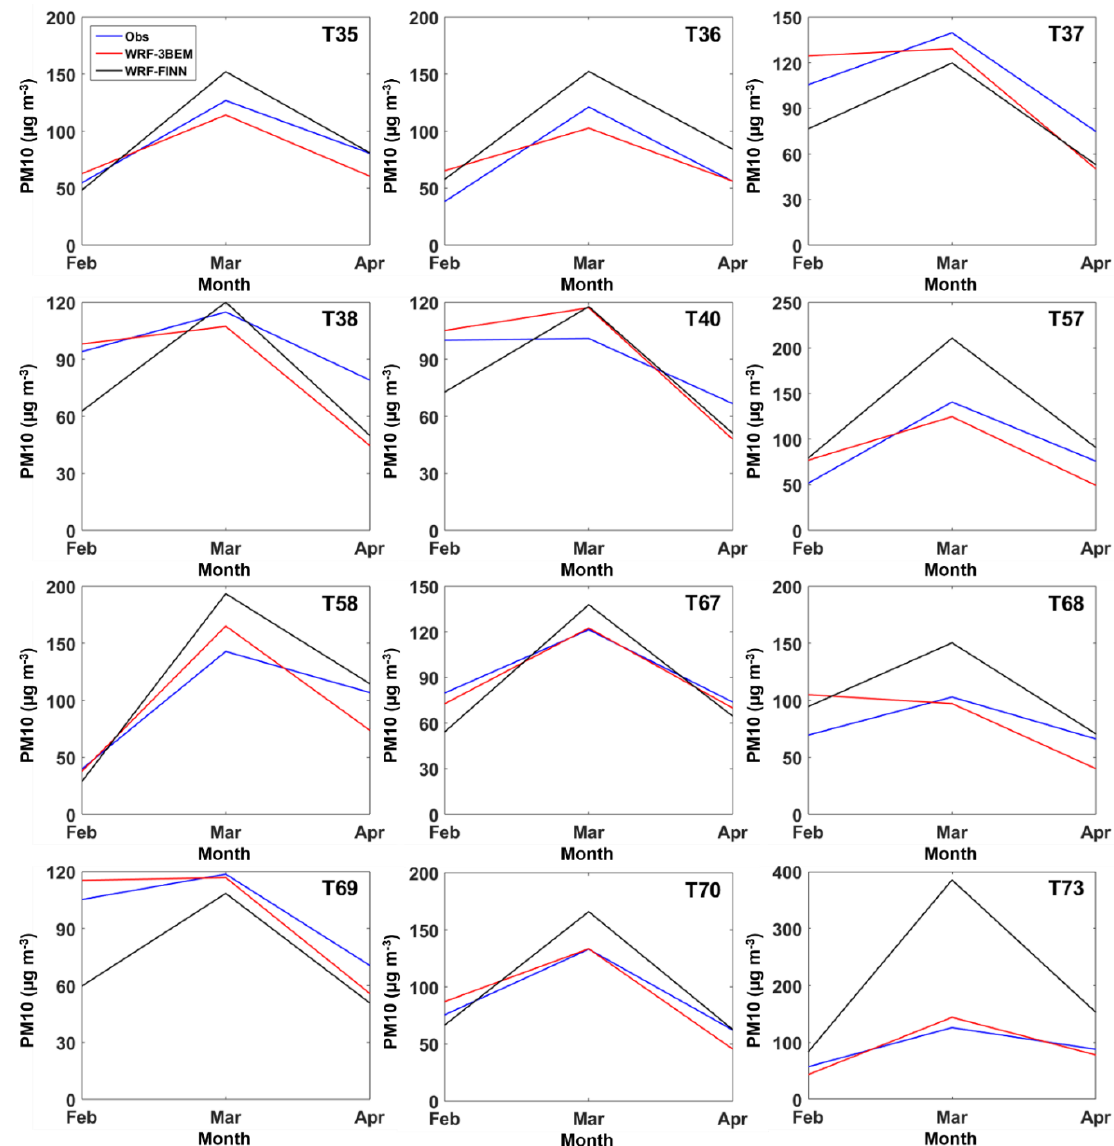
Figure 13. Comparisons of measured monthly average PM10 concentrations ( µ g m − 3 ) and simulations of WRF-3BEM and WRF-FINN for February–April 2014 for 12 ground stations.